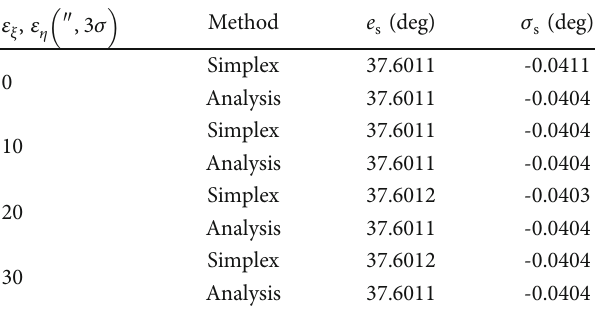
Table 6: Optimal navigation star with di ff erent star sensor measurement